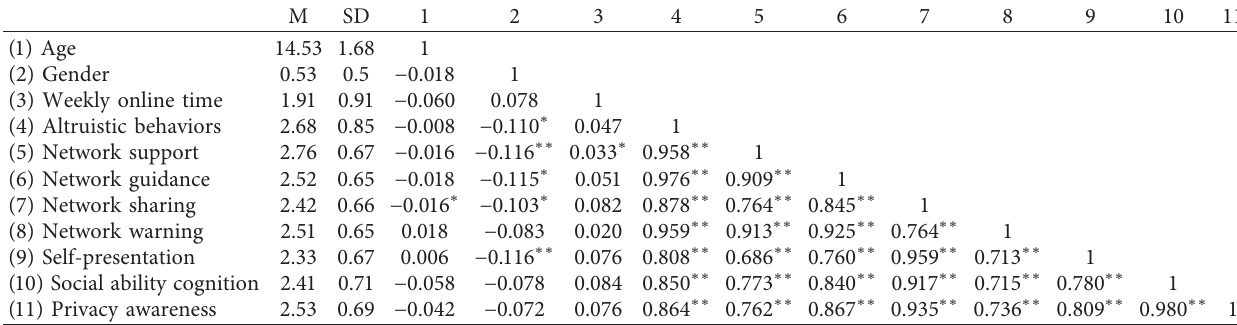
Table 1: Mean, standard deviation, and correlation coefficient of